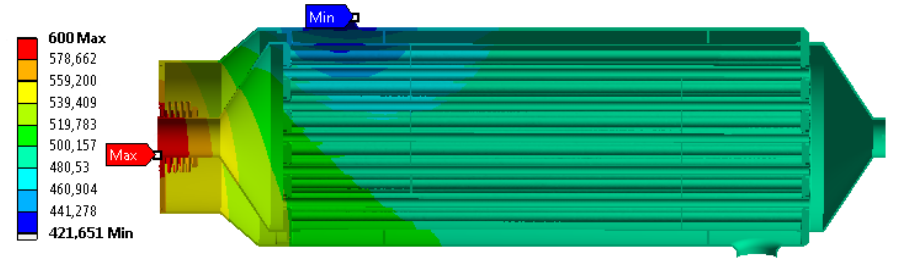
Figure 3: Temperature field applied to HE, °C